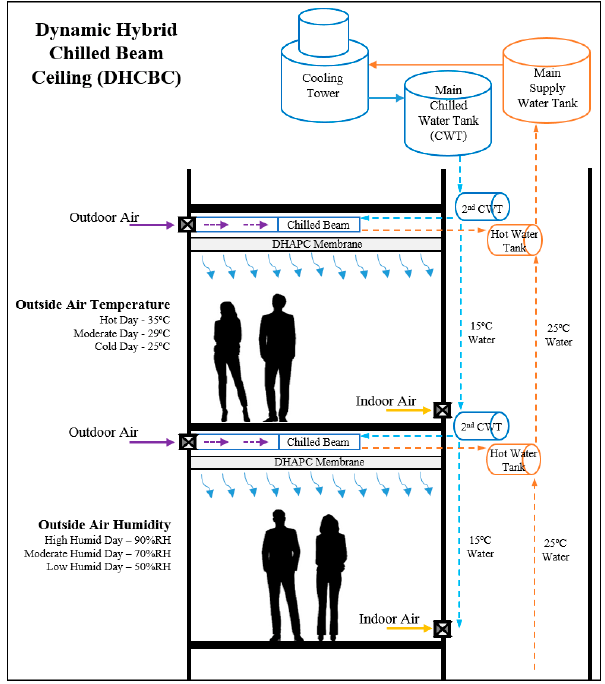
Figure 14. Dynamic hybrid chilled beam ceiling (DHCBC) schematic design in a high-rise building (not to scale).